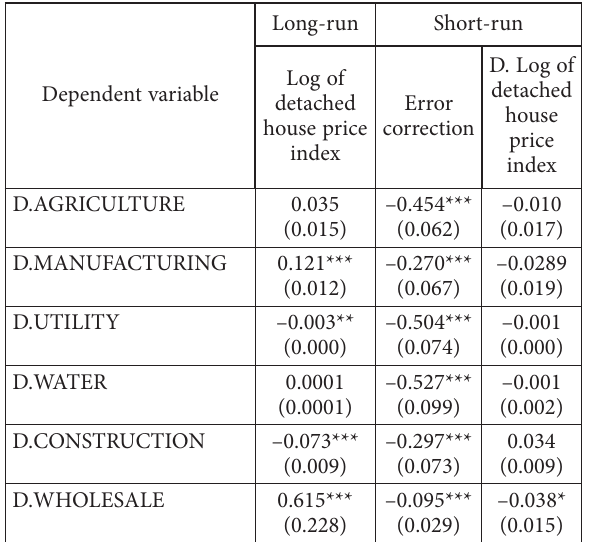
Table 6. Detached house price index and sub-sectoral business formation